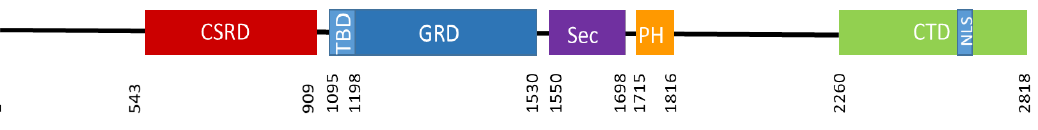
Figure 3. Schematic representation of neurofibromin domains. CSRD (cysteine- and serine-rich domain) in red, TBD (tubulin-binding domain) in light blue, GRD (GAP-related domain) in blue, Sec (Sec14 homologous domain) in purple, PH (pleckstrin homologous domain) in orange, CTD (C-terminal domain) in green, NLS (nuclear localization signal) in blue. The amino acid number is indicated